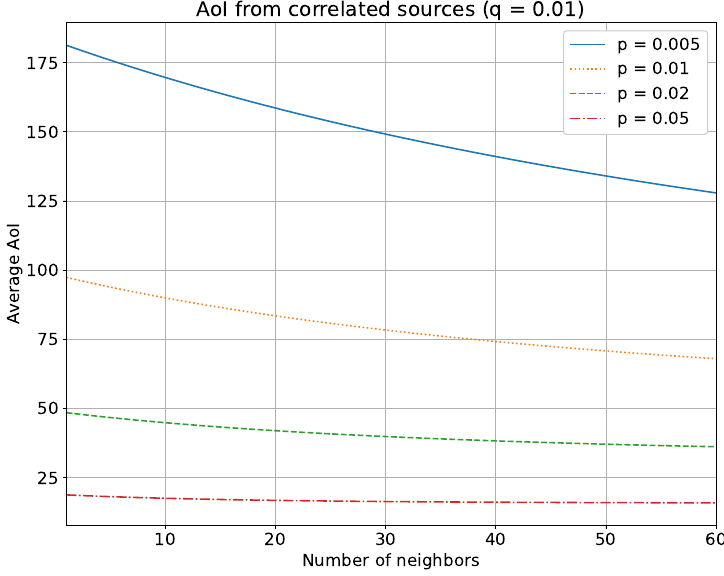
Figure 1. Behavior of the average AoI with a variable number of neighbors ( N ) in a loosely correlated scenario ( q = 0.01) with the concurrent access